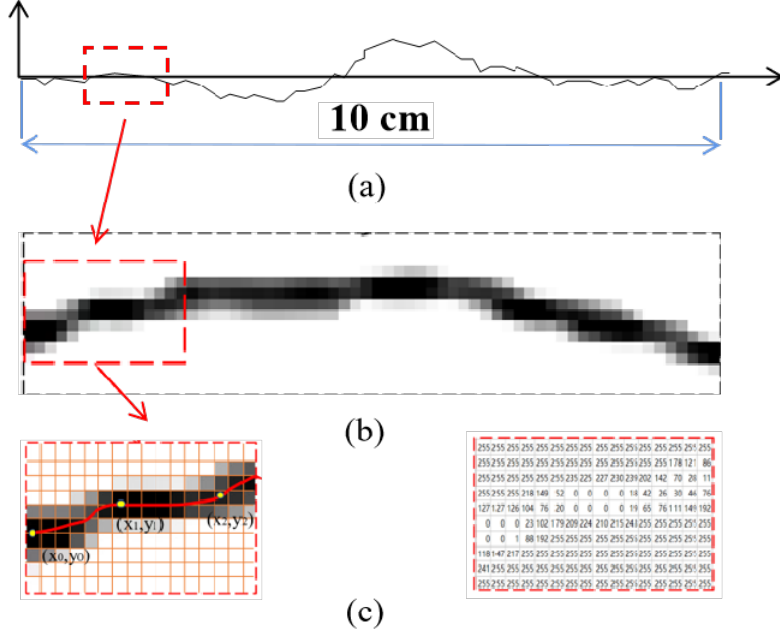
Figure 1. Extraction of coordinate points. ( a ) standard JRC profile with value of 18–20 ( b ) basic gray image ( c ) gray matrix and intensity matrix.